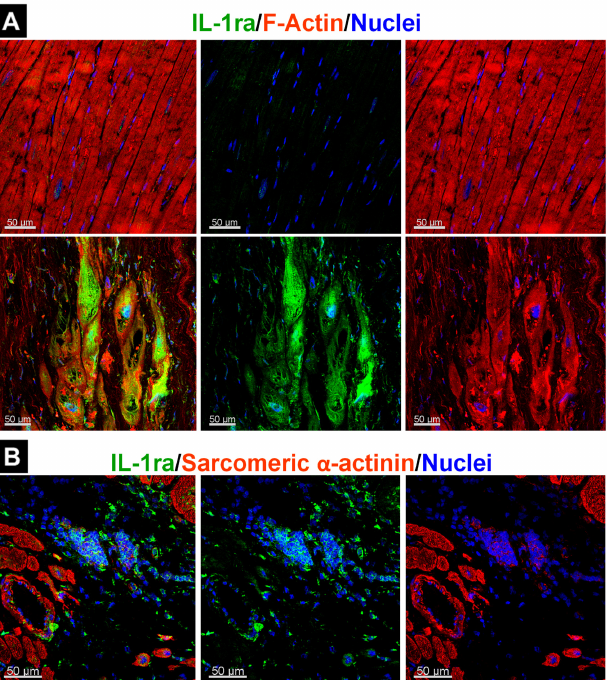
Figure 5. Localization of the interleukin-1 receptor antagonist (IL-1ra) is influenced by the underlying disease. ( A ) IL-1ra in cardiomyocytes of a patient with ischemic cardiomyopathy. ( B ) IL-1ra in the granuloma of a patient with cardiac sarcoidosis. Under conditions of increased stress, spatially and temporarily limited activation of the OSMR cascade supports the reorganization of the intercalated discs (ID) to avoid del- eterious distortion and provide the basis for an enhanced myofibrillogenesis. As a result of hypertrophic growth, cardiomyocytes will increase in length and width, with a marked accumulation of sarcomeres (Figure 6). At an early stage, some degree of hypertrophy is reversible, for example, after valve replacement or pregnancy, since cardiomyocyte con- tacts are essentially preserved and functional. The increase in growth-promoting sub- stances such as fibroblast growth (FGFs) and insulin-like growth factors (IGFs), combined with a concomitant decrease in OSM receptor signaling cascades, supports the develop- ment of hypertrophic cardiomyocytes. However, when dying or degenerating cardiomy- ocytes disrupt intercellular communication, mechanical transmission of force is impaired and life-sustaining fetal remodeling of cardiomyocytes must occur (Figure 6). This is es- pecially evident after acute myocardial infarction. Invading neutrophil granulocytes acti- vate OSMR and LIFR signaling cascades in cardiomyocytes and initiate repair processes